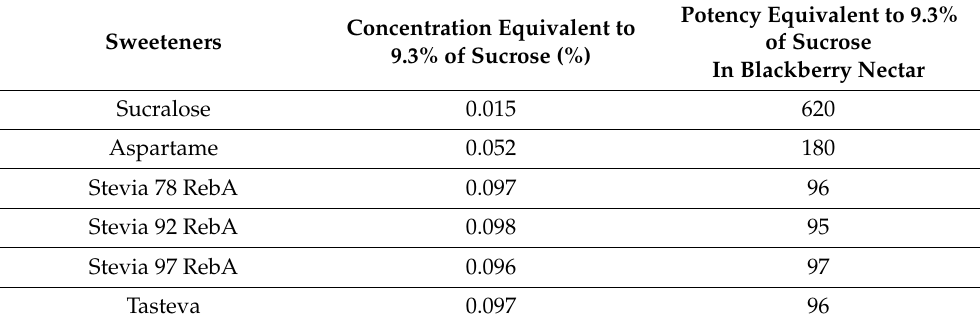
Figure 2. Concentration and sweet stimulus intensity on a logarithmic scale. Table 3. Concentration equivalent to 9.3% of sucrose and equivalent power of sweetener in blackberry nectar.